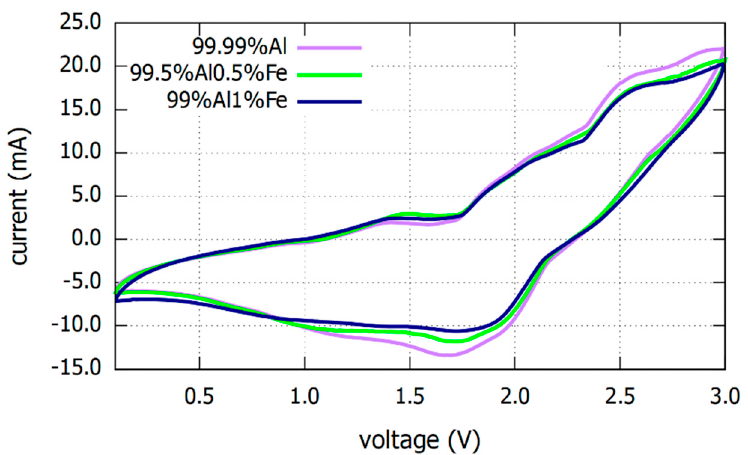
Figure 1. Cyclic voltammetry (CV) graphs of Al-NG battery using Al alloy anodes with various Fe content under the voltage range of 0.1–3V at a scan rate of 5 mVs –1 from cycle no 5.